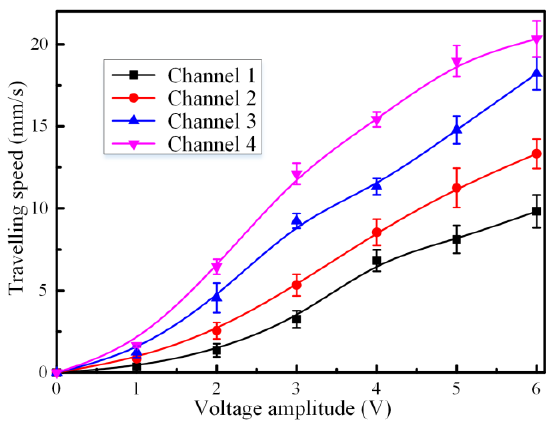
Figure 4. Plot of pumping velocity versus signal amplitude for liquid metal upon the application of a 150 Hz sinusoidal wave signal at 4 Vpp at the electrolyte concentration of